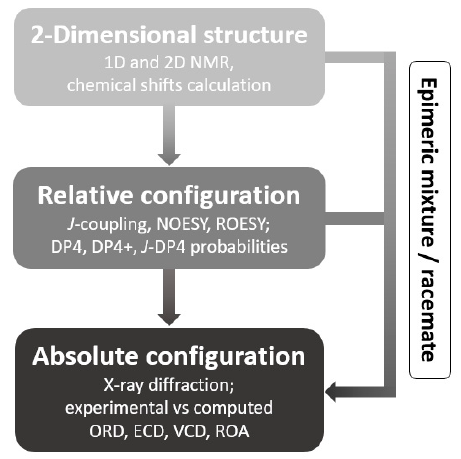
Figure 1. General Structural Elucidation Workflow.